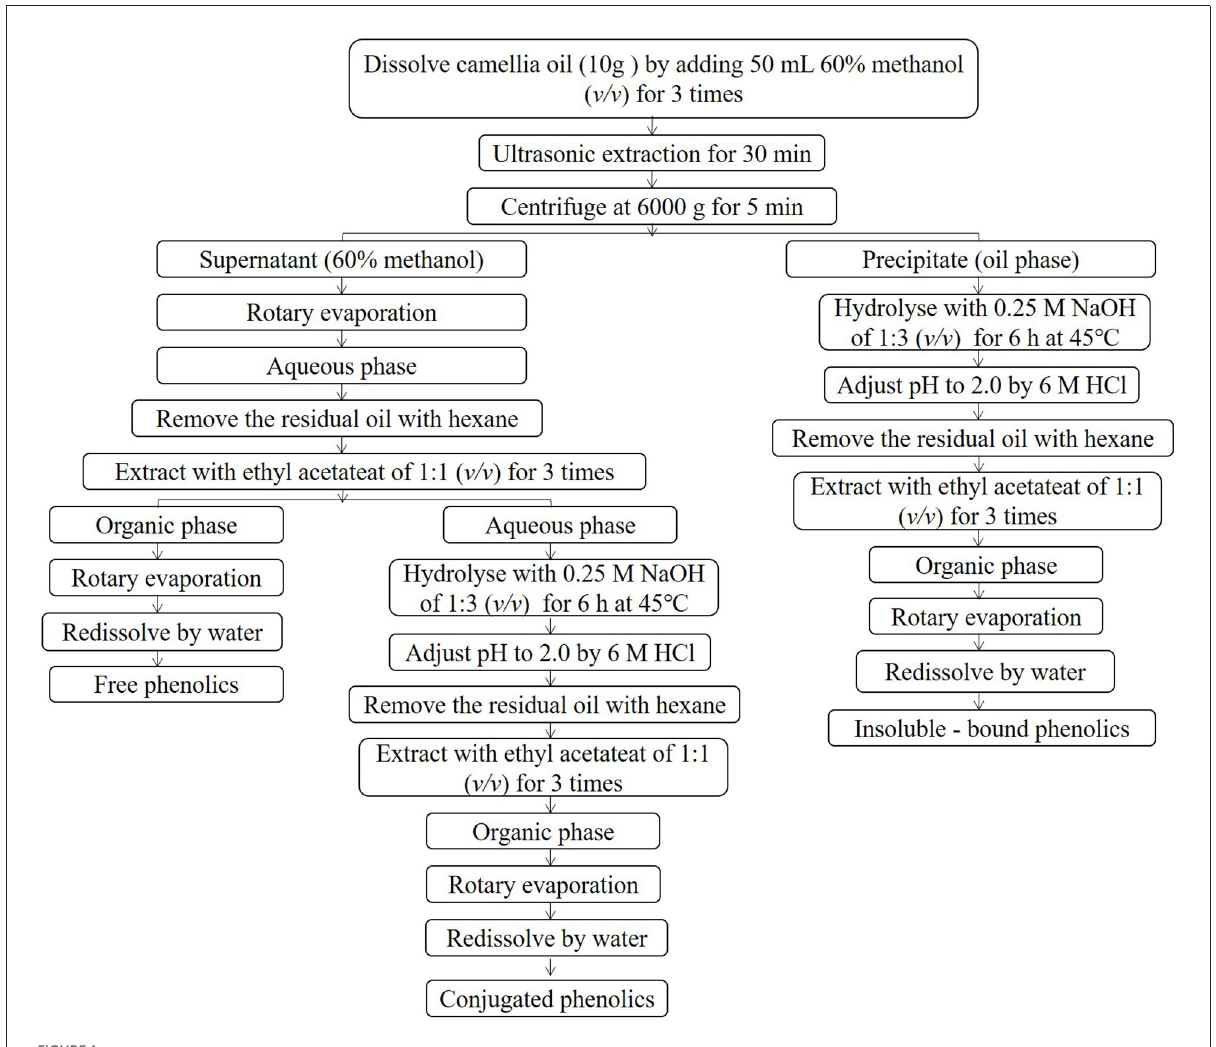
FIGURE1 Extraction procedure of the three forms of phenolics in camellia